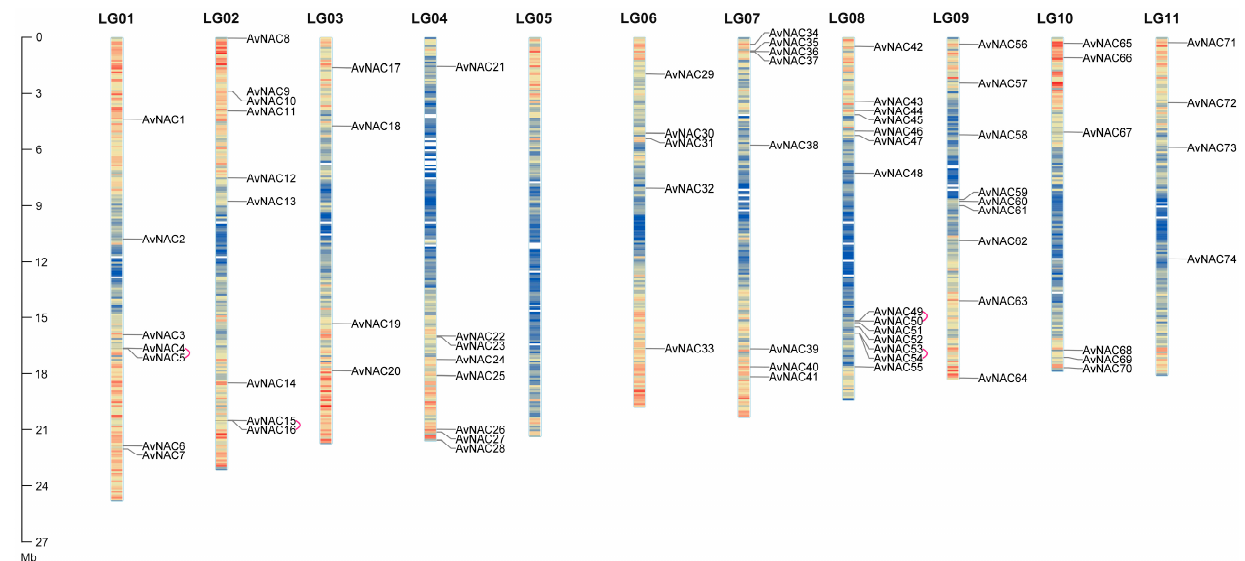
Figure 1. The distribution of AvNACs on chromosomes. Heatmaps on chromosomes represent gene density, from low to high in blue and red, respectively. The gene pairs of tandem duplication are marked with pink connecting lines.